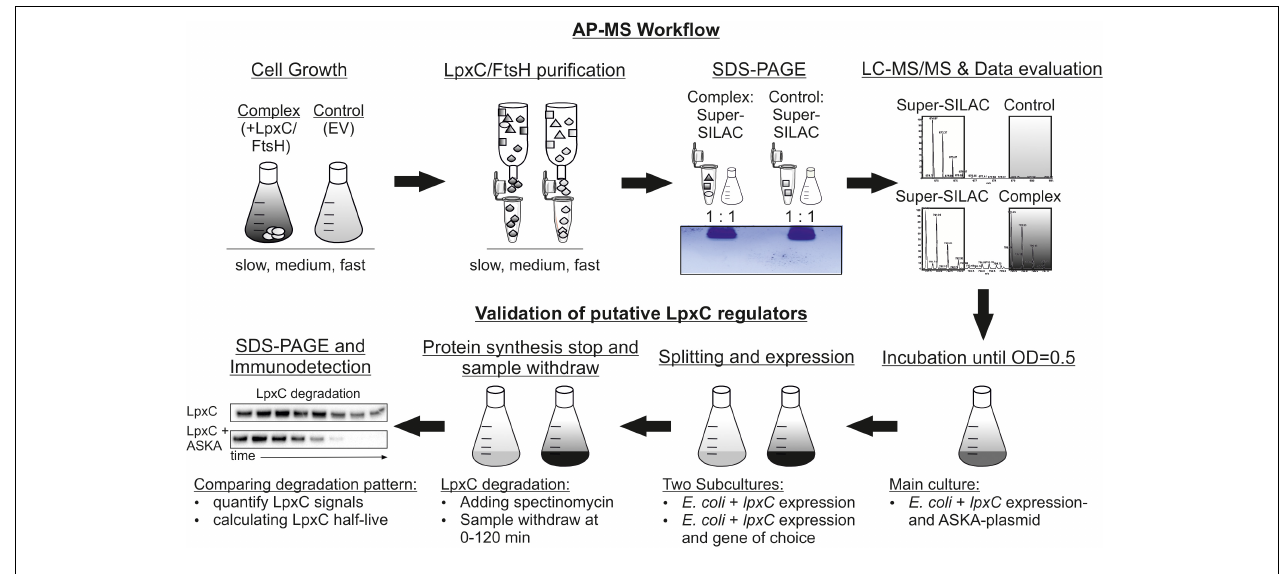
FIGURE 1 | Experimental workflow to identify novel LpxC regulators by a super-SILAC quantification LC-MS approach. Plasmid-encoded Strep-LpxC or His 6 -MBP-FtsH (complex) proteins were overproduced at different growth rates (slow, medium and fast) in the Escherichia coli (cid:49) arg / (cid:49) lys strain with the corresponding EV (control). The internal super-SILAC standard contained labeled Arg 10 and Lys 8 . After cell disruption, LpxC and FtsH variants were purified and mixed with equal amounts with the super-SILAC standard before purified proteins were identified using a short-gel LC-MS/MS approach. Statistically enriched proteins at single growth rates were validated using in vivo degradation experiments. An E. coli WT culture containing an lpxC and a gene of choice expression plasmid (ASKA-plasmid) were incubated until exponential growth-phase. The culture was split in two subcultures and lpxC and gene of choice expression were induced in the first subculture and only lpxC expression in the second as control. Translation was stopped by addition of spectinomycin and samples were taken between 0 and 120 min. After SDS-PAGE and immunodetection with an LpxC antibody half-life was calculated. AP-MS, affinity purification-mass spectrometry; EV, empty